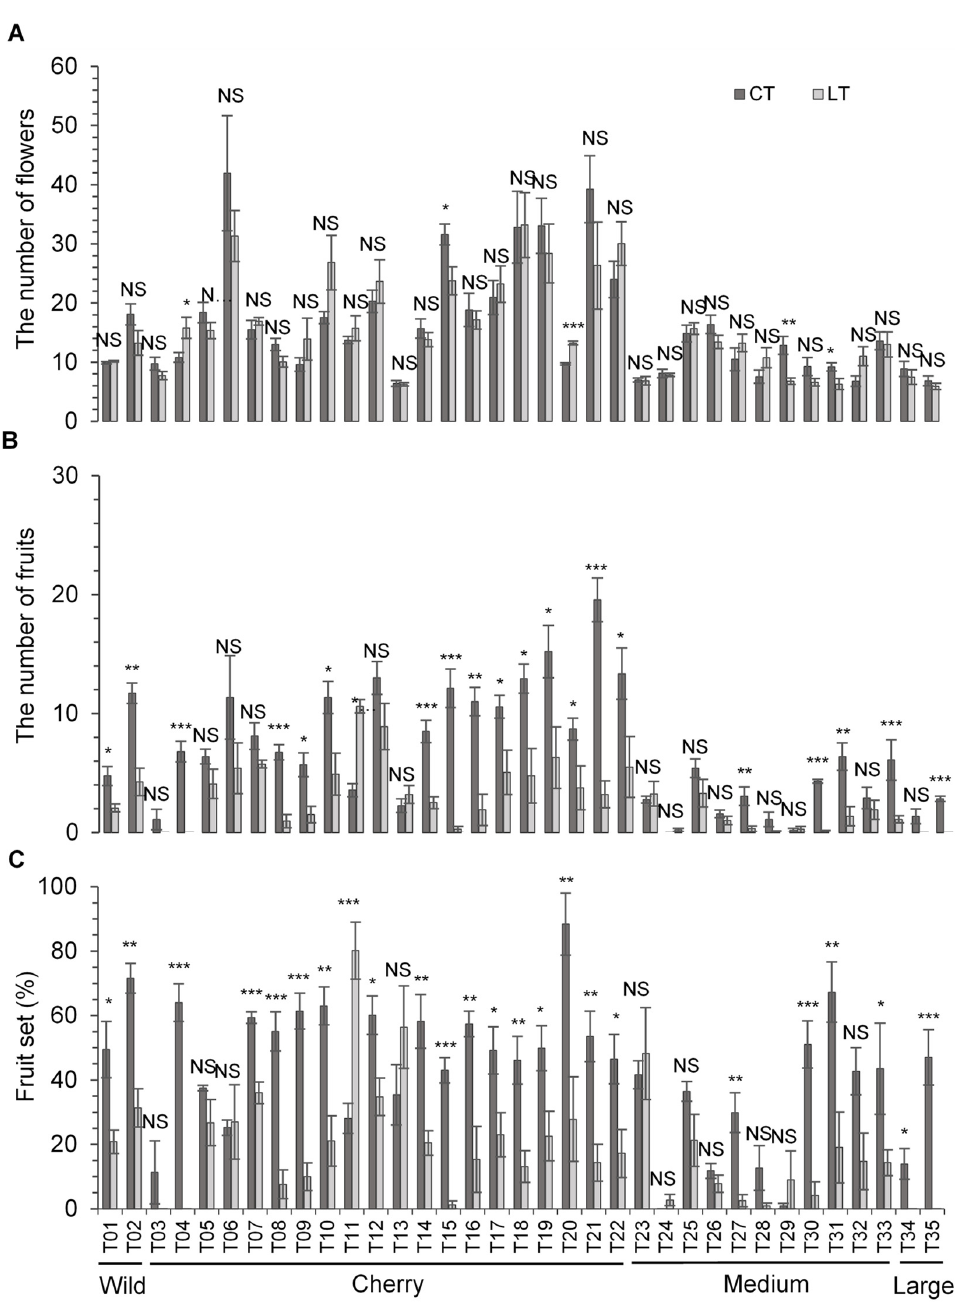
Figure 3. The analysis of reproductive traits on ( A ) the number of flowers, ( B ) the number of fruits, and ( C ) fruit set among 35 tomato accessions with different fruit types under CT and LT greenhouses. Significant differences were evaluated with Student’s t -test ( p ≤ 0.05, p ≤ 0.01, and p ≤ 0.001) and are denoted by *, **, and ***, respectively. NS indicates not significant and bars indicate ± standard deviations ( n =